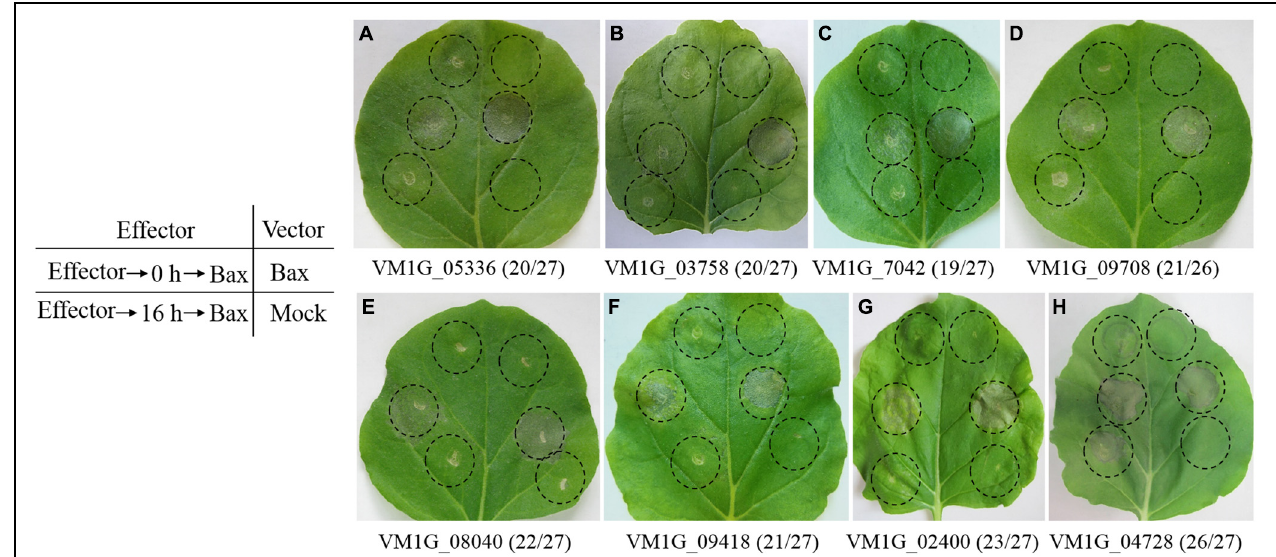
FIGURE 2 | Symptoms of transient expression of CEPs in Nicotiana benthamiana leaves after agro-infiltration. (A–G) Seven VmEPs suppress BAX-induced cell death. (H) Most CEPs, like VM1G_04728, could not suppress BAX-induced PCD. Leaves were infiltrated with A. tumefaciens containing a PVX